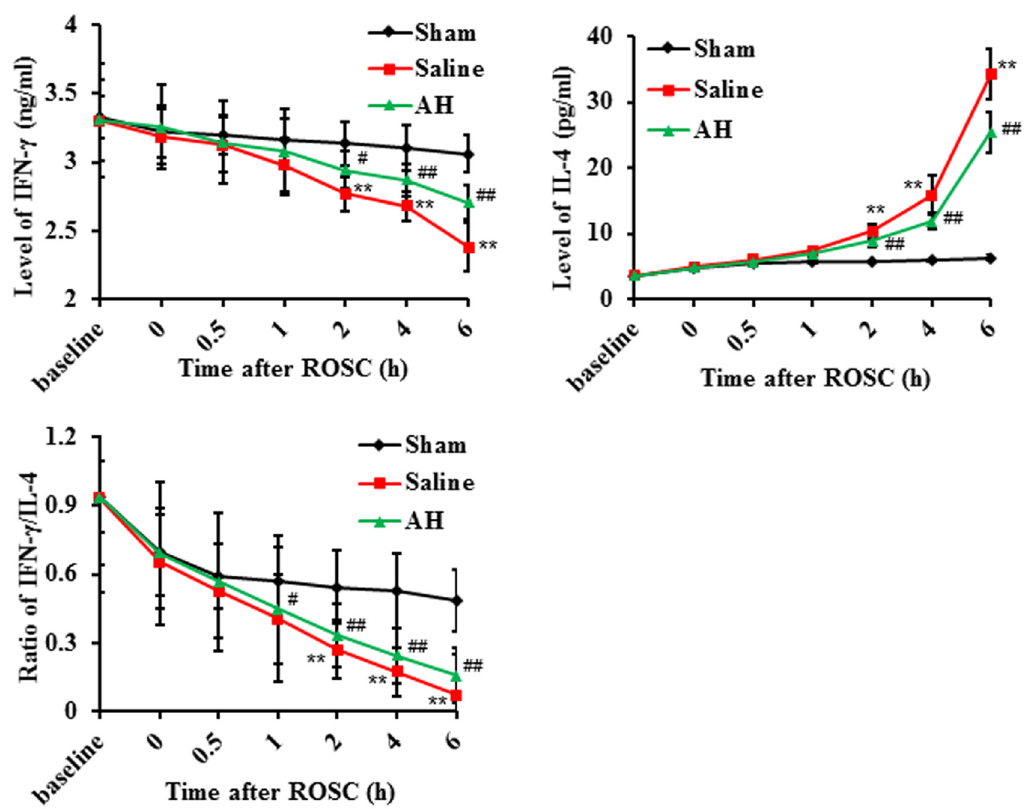
FIGURE 1 - AH treatment inhibited Th1-Th2 transformation in the blood. Blood samples were collected at baseline, 0, 0.5, 1, 2, 4 and 6 h after ROSC. Compared with the Saline group, AH treatment significantly increased IFN-γ level, decreased IL-4 level and increased the ratio of IFN-γ to IL-4 in serum. Data were expressed as mean ± SD (n = 8). ** p < 0.01 vs. Sham group. # p < 0.05, ## p < 0.01 vs. Saline